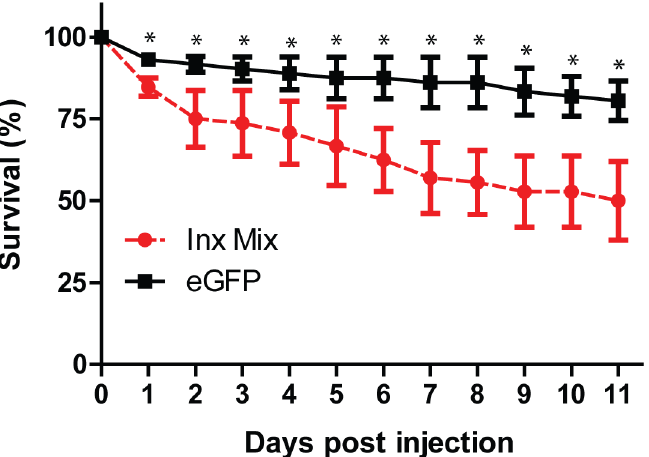
Fig 7. Effect of eGFP (black squares) and innexin (red circles) dsRNA injection on mosquito survival. Values are means ± SEM. n = 3 replicates of 24 mosquitoes. Asterisks indicate a significant difference in survival between eGFP and innexin dsRNA injected mosquitoes as determined by a two-way ANOVA with a Holm-Sidak ’ s post-hoc test.